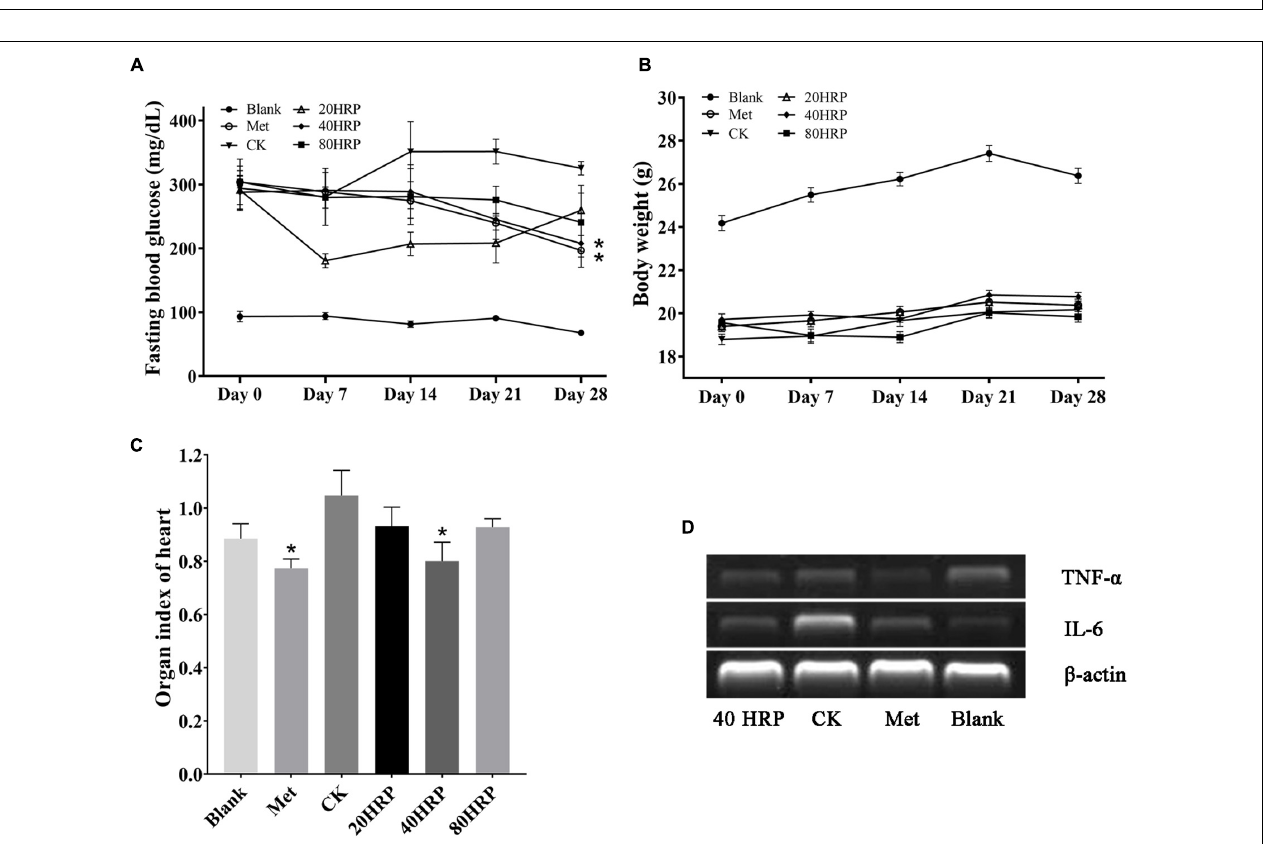
Frontiers in Nutrition |